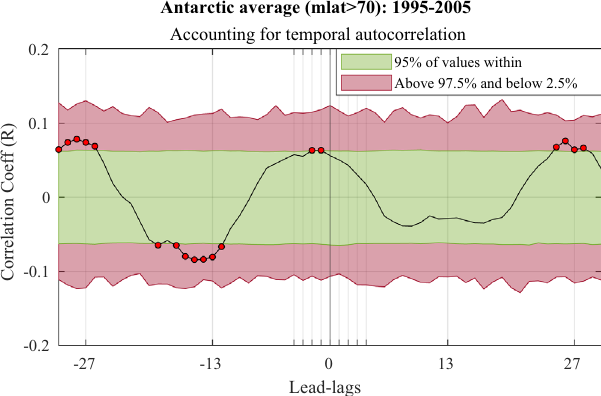
Fig. 5. The signi fi cance level for the lead – lag correlation coef fi cients after 3000 MC-iterations for the period 1995 – 2005. The red area equates to a p -value of 0.05. The green region shows where 95% of all values land for every lead – lag after 3000 iterations. Note that the signi fi cant data points (dark red circles) represent individual hypothesis tests before false detection rate method is